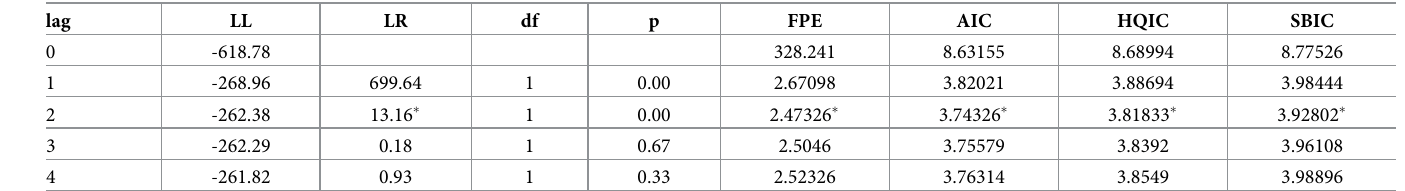
Table 8. Lag order